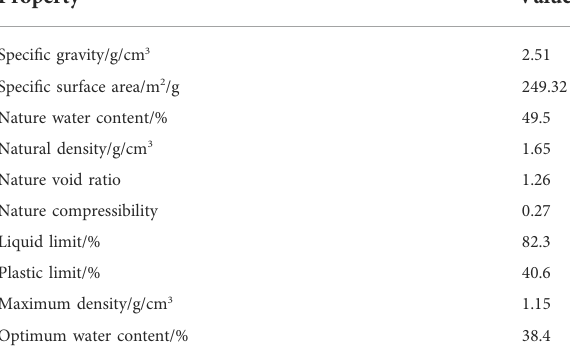
TABLE 2 Basic physicochemical properties of